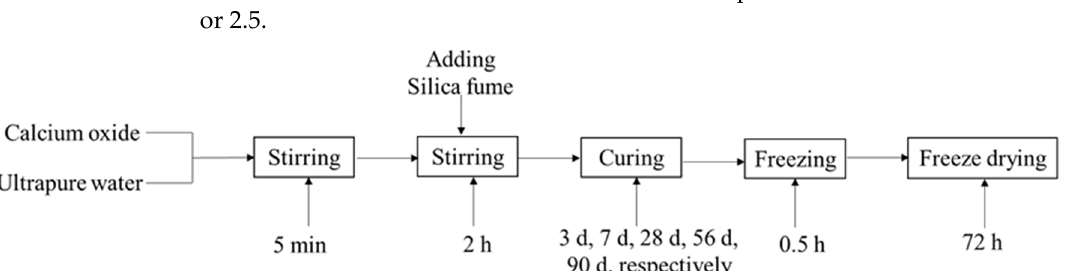
Figure 3. Experimental scheme.